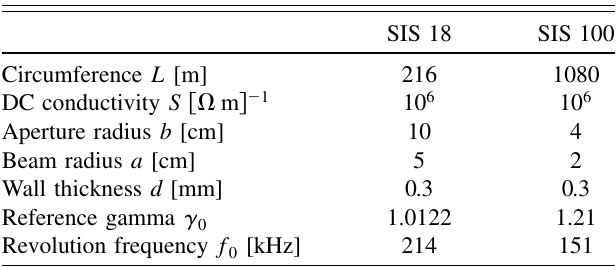
TABLE I. Machine